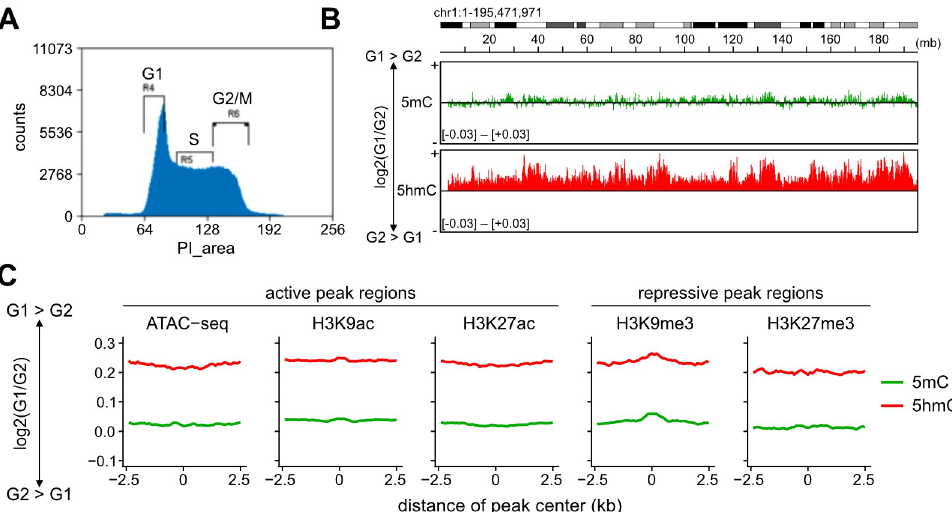
Fig 2. Restricted de novo DNA methylation after DNA replication in 1KO ESCs. ( A ) Cells were subdivided and collected using fluorescence-activated cell sorting (FACS) into the following two populations: either in G1 to early S phase (G1) or in late S to M via G2 phase (G2). Using MeDIP-seq and hMeDIP-seq, the distribution patterns of 5mC and 5hmC in the G1 and G2 populations were compared. ( B ) Differences in DNA modification patterns between G1 to G2. Chromosome 1 is shown as an example. The vertical axis takes a positive value when G1 is higher and a negative value when the G2 is higher. ( C ) Line plots showing the difference in 5mC and 5hmC between G1 and G2 of 1KO ESCs around ATAC-seq and histone modification peaks ( ± 2.5 kb). Sequencing data from WT ESCs (GSE90895) was used to identify peaks for ATAC-seq and each type of histone